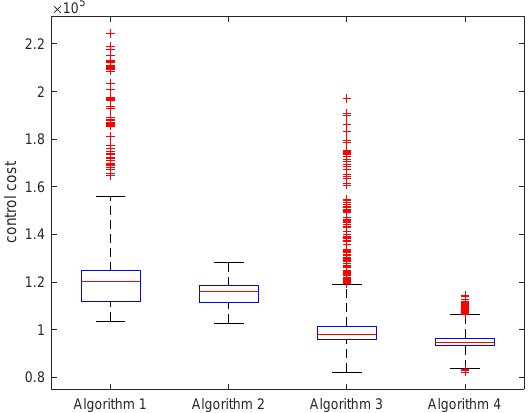
Figure 12. The control cost of Algorithms